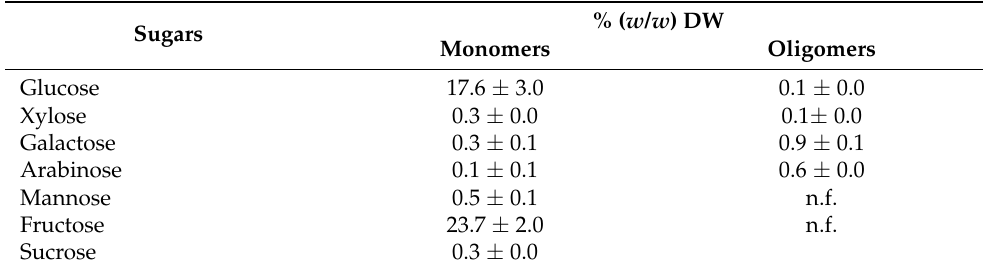
Table 7. Sugars composition in aqueous extract in culled tomato residue. Data expressed as percent- age ( w/w ) on a DW basis.